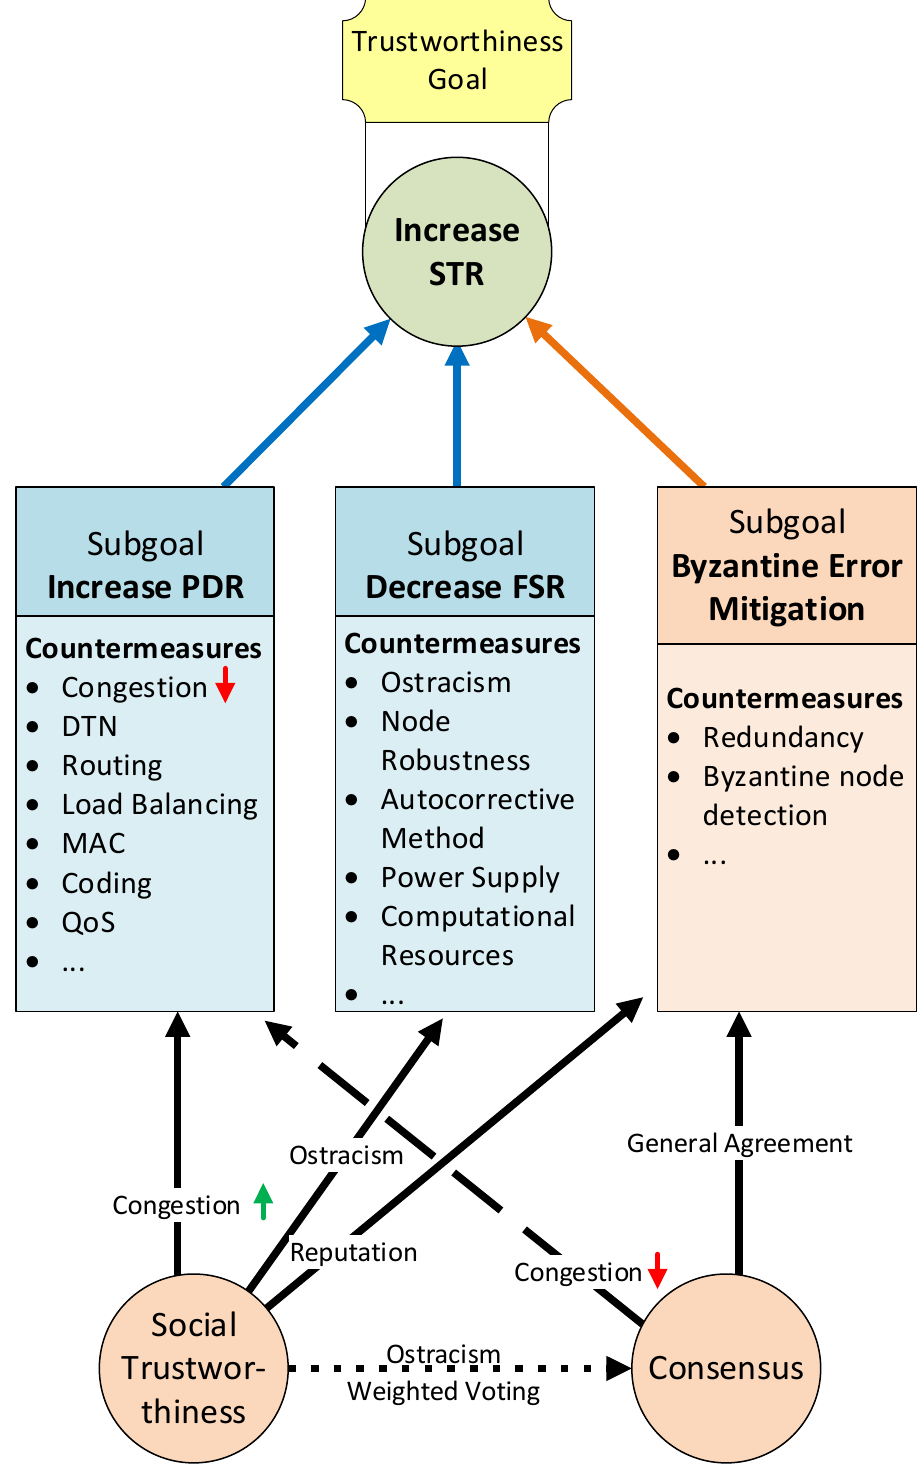
Figure 8. Trustworthiness model goals and countermeasures relationship. Moreover, we have two transversal actions that affect more than one subgoal. These transversal actions implement the extension layers of our model: the Consensus Layer and the Social Trustworthiness Layer. Continuous-line arrows indicate a positive outcome, discontinuous-line arrows indicate a negative outcome, and dotted-line arrows indicate an uncertain outcome. Using social trustworthiness can reduce network congestion thanks to the ostracism of nodes with the worst reputation and send only the values from nodes with the highest reputation to the control center. Social trustworthiness also helps to reduce the FSR thanks to the ostracism of bad reputation nodes. It also leverages the mitigation of byzantine errors because only values from high reputation nodes (leaders) are trusted.